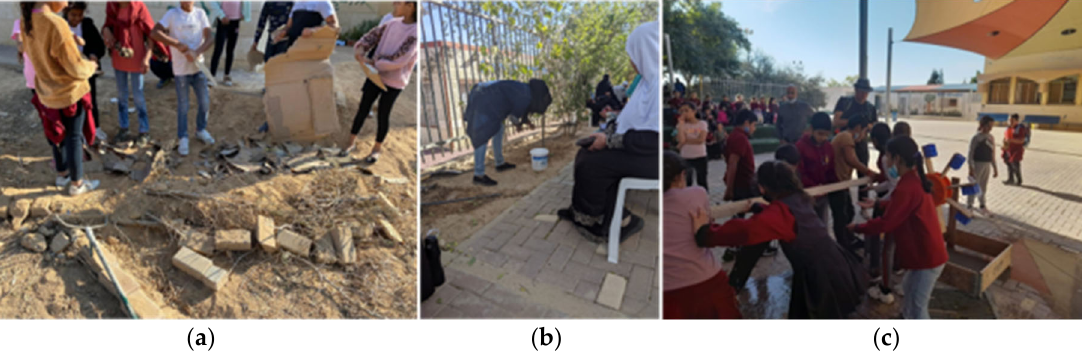
Figure 14. ( a – c ) Women and children participating in ‘Desert Water’ and ‘Desert Agriculture’ work- shops, “Desert Sustainability and Art” Festival, Kuseife, 2021. Photographed by Dan Farberoff. Images courtesy of the artist.